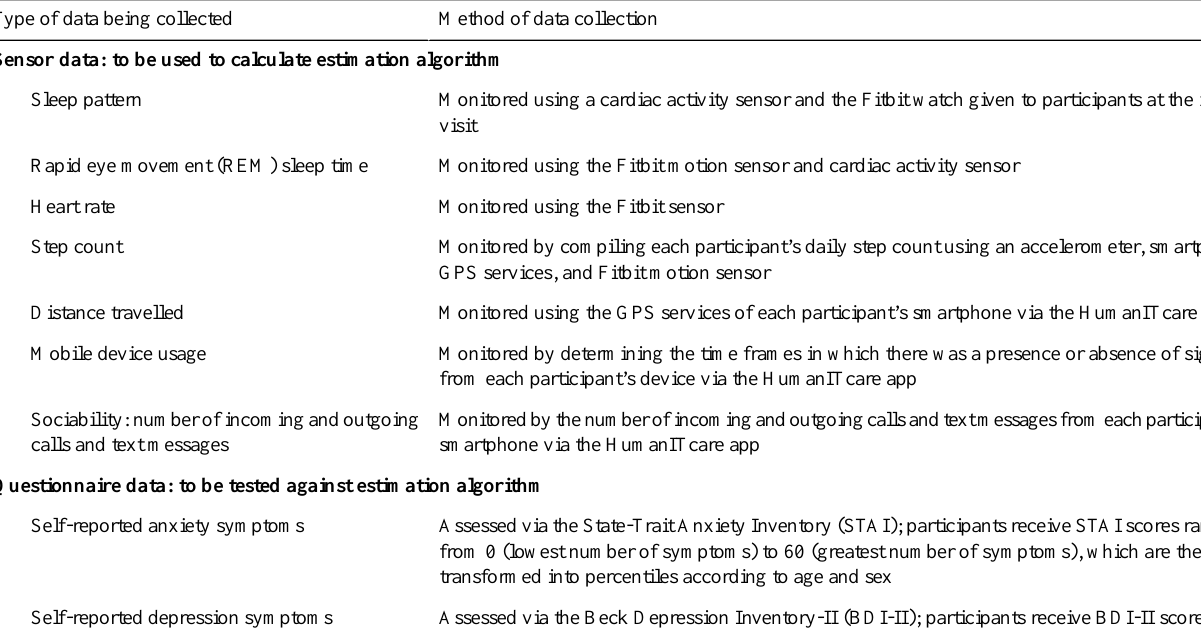
Method of data collectionType of data being collected